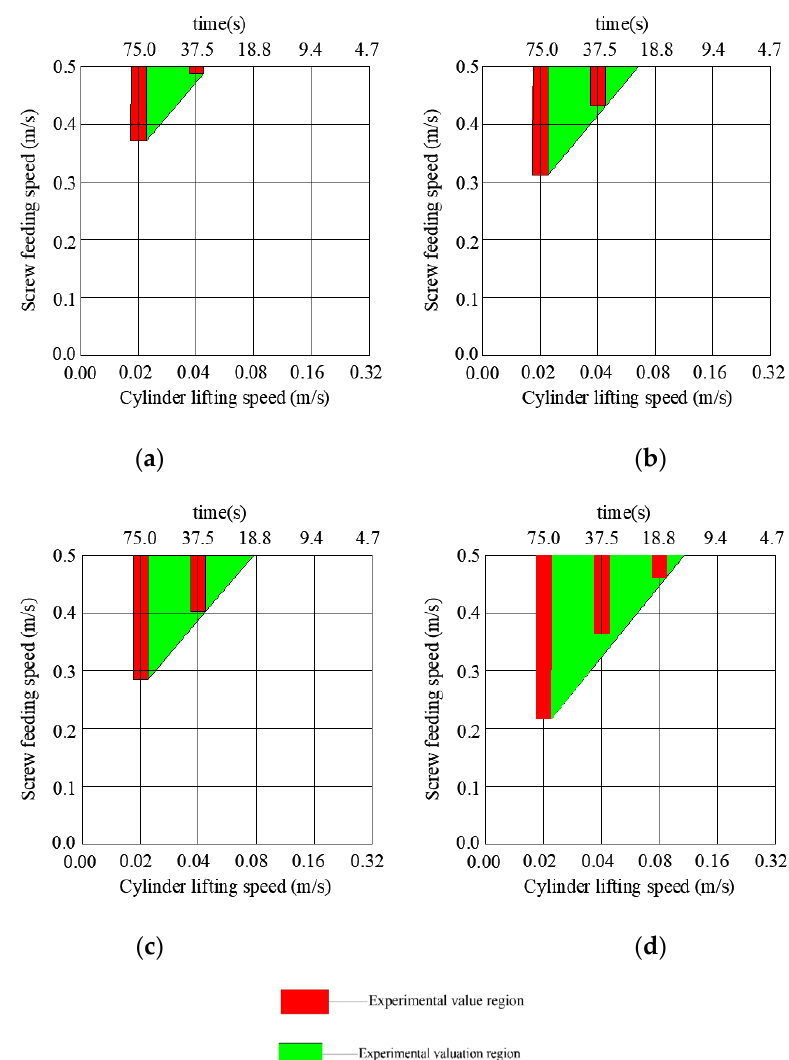
Figure 9. The influence of moisture content of coking coal on transporting characteristics. ( a ) The moisture content is 3%; ( b ) The moisture content is 5%; ( c ) The moisture content is 7%; ( d ) The moisture content is 9%